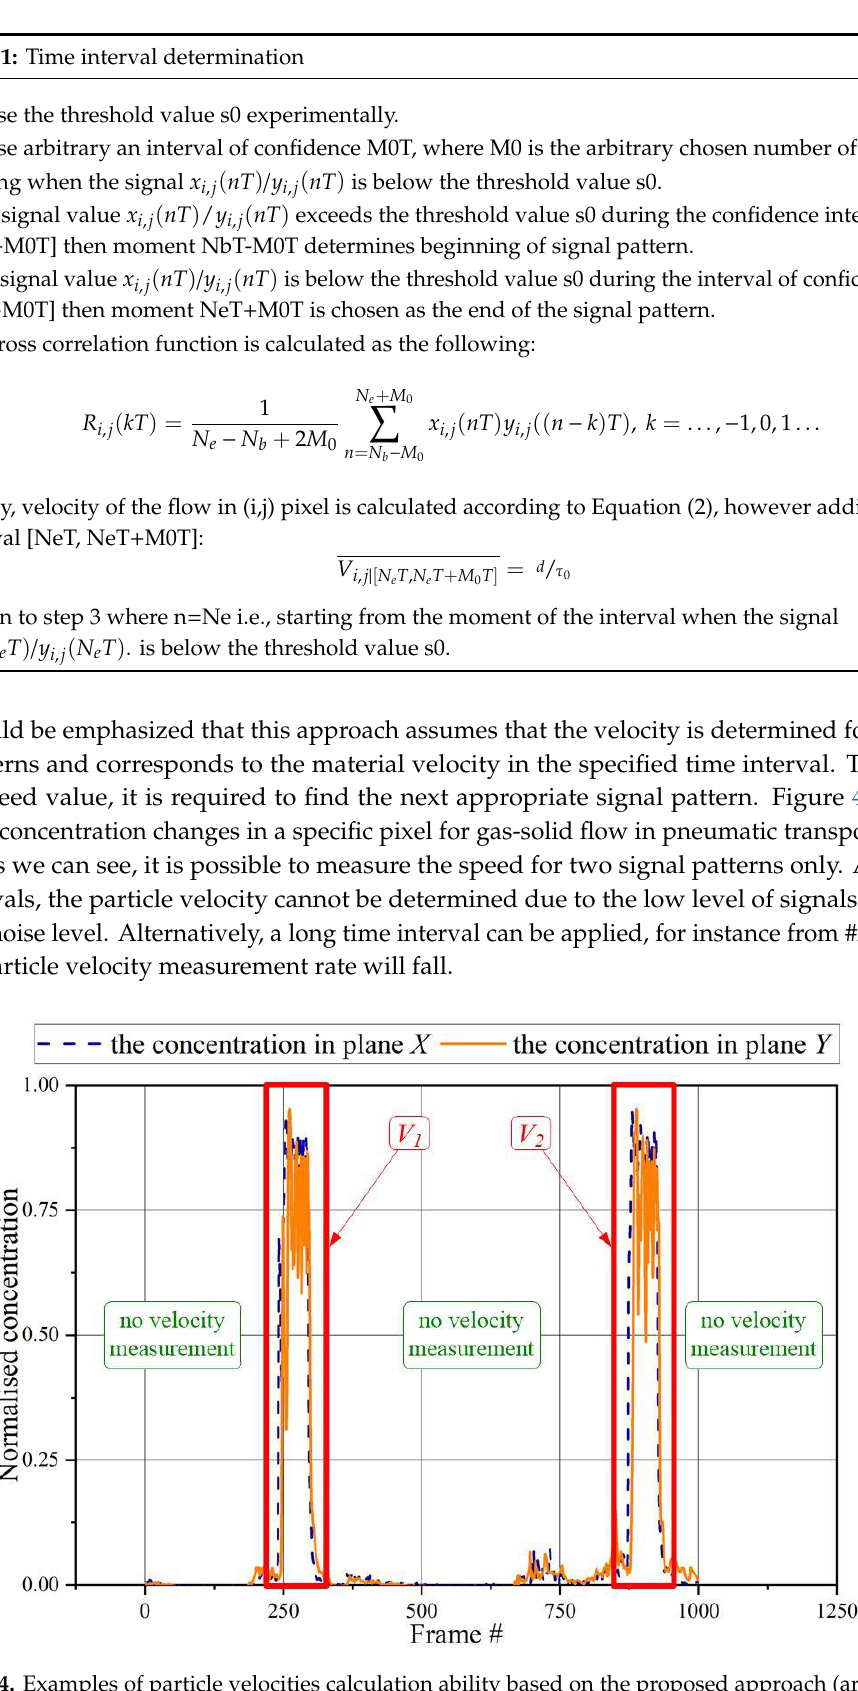
Figure 4. Examples of particle velocities calculation ability based on the proposed approach (arbitrary chosen threshold s 0 = 0.1). The normalized concentration in the chosen pixel (15,15).